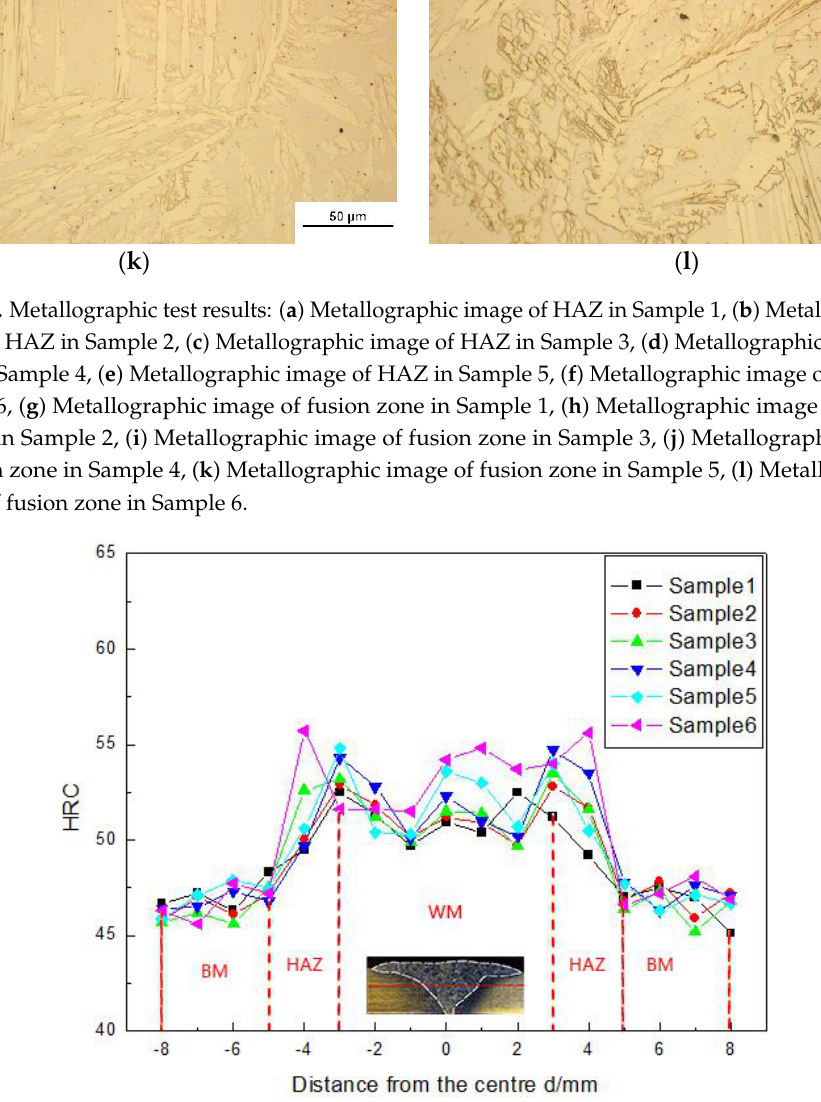
Figure 6. Rockwell hardness distribution in welded joints.